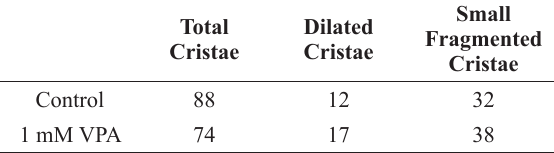
Absolute number of mitochondrial cristae from control cells and 1mM VPA treated